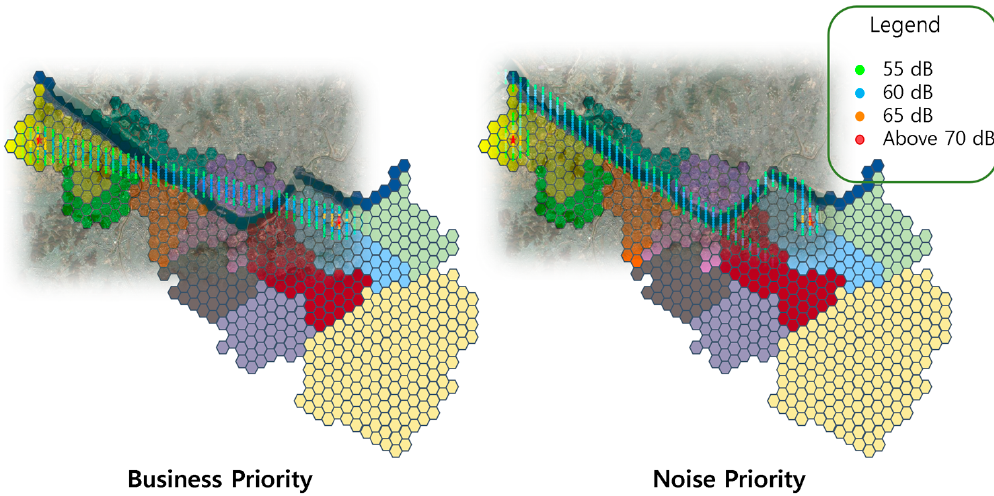
noise-exposure ratio in the Miedema curve [22], and the number of people affected by high levels of noise in each scenario is shown in Table 11.